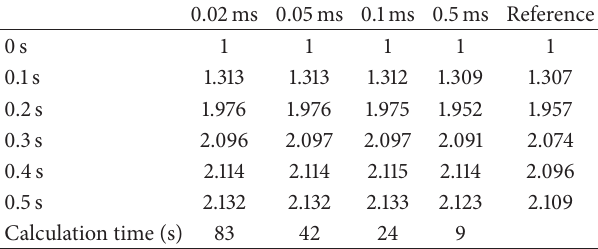
Table 8: Normalized power versus time with different time step in TWIGL problem during ramp perturbation.